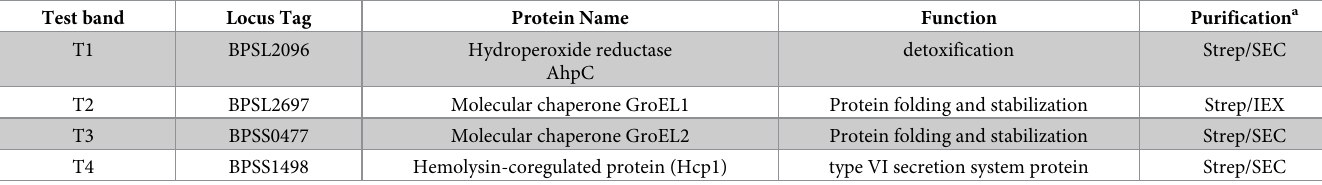
Table 1. Burkholderia pseudomallei protein antigens used in the dipstick assay. Test